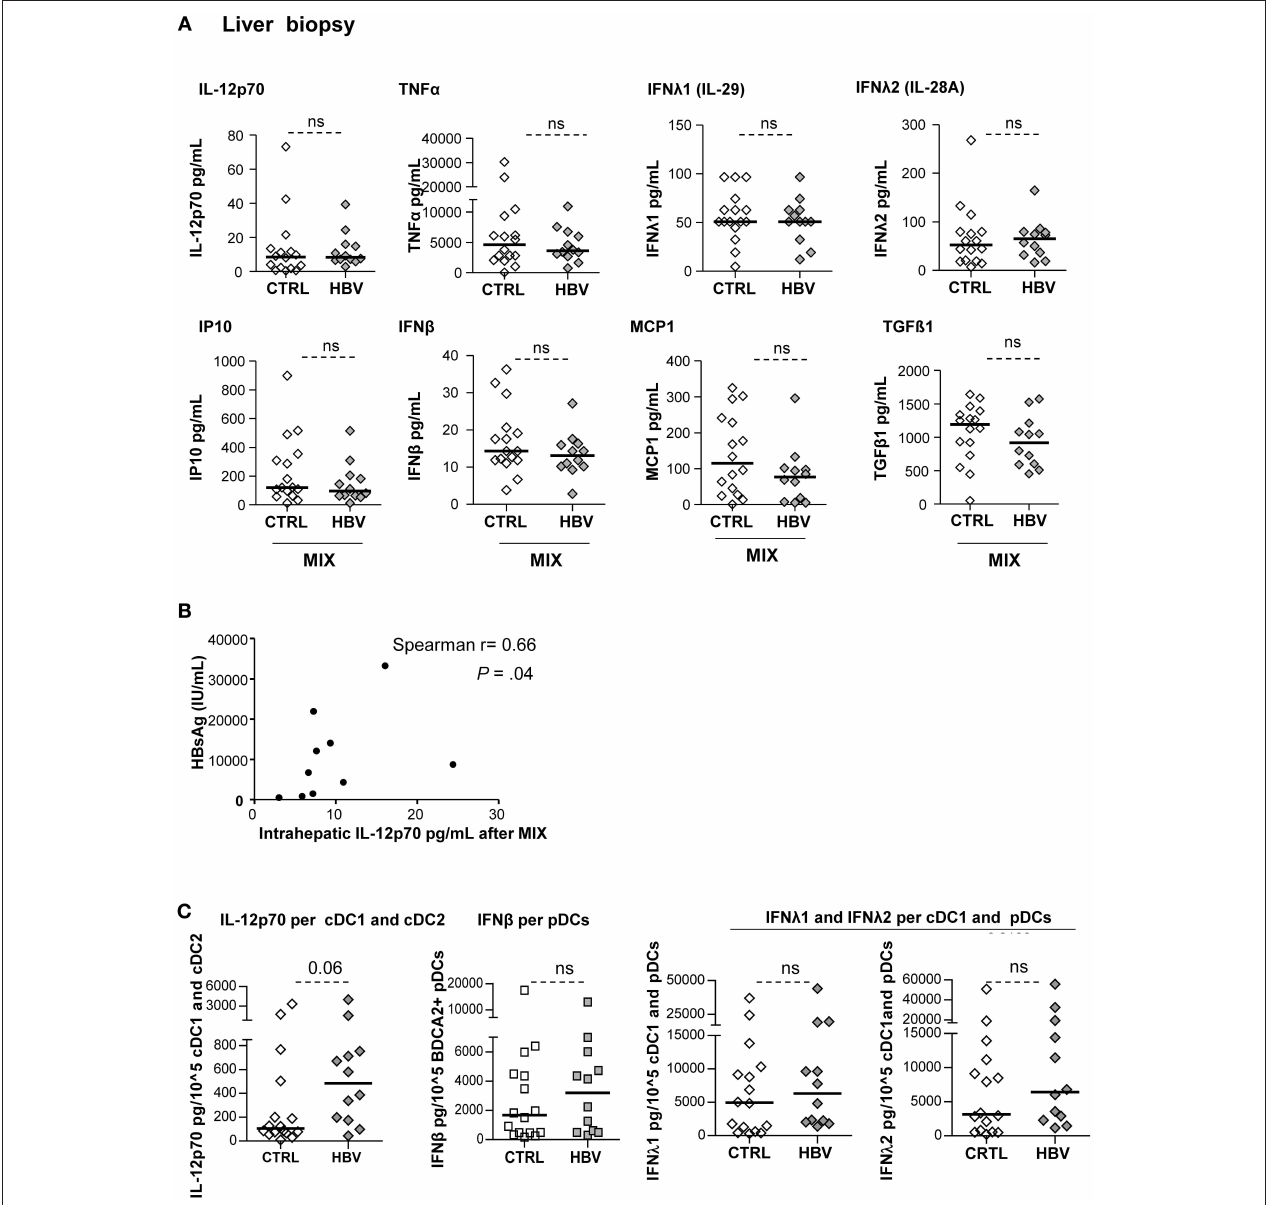
FIGURE 7 | Improvement of cytokine secretion by LMNCs in chronic HBV patients upon TLR triggering. LMNCs (1 × 10 6 cells/ml) from non-viral infected controls or HBV patients were stimulated for 22h with a mixture of TLRL (MIX:polyI:C + R848 + CPG A ) and the culture supernatants were examined for the presence of IL-12p70, IFN β , IFN λ 1, IFN λ 2, TNF α , IP10, MCP1, IL-10, and TGF-ß1 by Luminex technology. (A) Quantification of cytokine secretion in the supernatants. Open symbols, HD ( n = 16); filled symbols, HBV ( n = 11–12). P -values were calculated using Mann–Whitney test. (B) Spearman correlation between the IL-12p70 secretion by intrahepatic LMNCs from HBV patients with plasmatic HBsAg levels ( n = 10). (C) Cytokine’s secretion by liver cell suspensions were reported to the absolute number of DCs present in samples before stimulation with the mix of TLRLs (amount of cytokine/10 5 DC) as shown for cDC2 + cDC1 (IL-12p70), pDCs (IFN β ) and cDC1 + pDCs (IFN λ 1, IFN λ 2). Open symbols, HD ( n = 16–17); filled symbols, HBV ( n = 28–30). P -values were calculated using Mann–Whitney test. P -values were calculated using Man-Whitney test (dashed